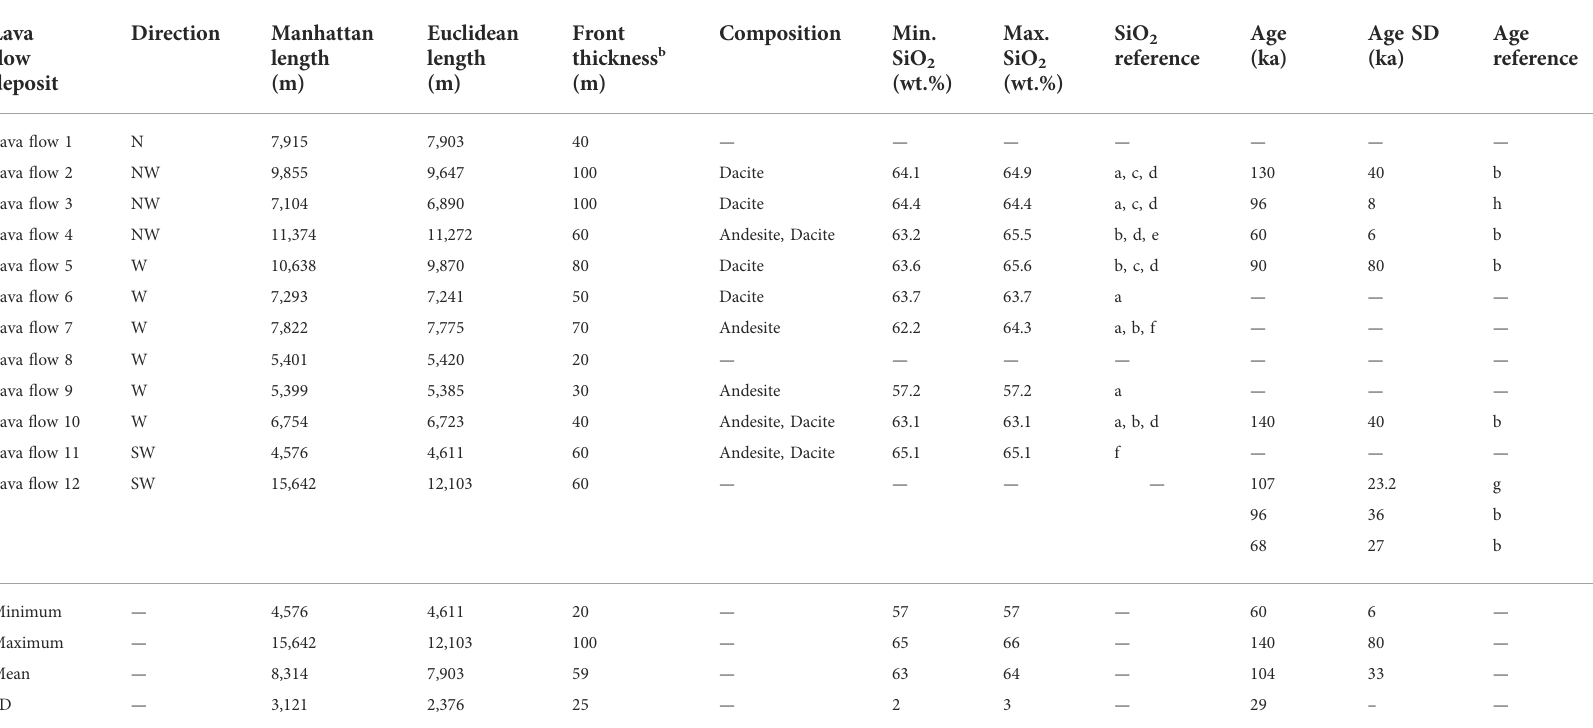
TABLE 2 Physical and geochemical data of the 12 lava fl ow deposits of the San Pedro volcano. a Francis et al. (1974a); b Bertin and Amigo (2019); c Mamani et al. (2008); d Godoy et al. (2014); e Godoy et al. (2017); f O ’ Callaghan and Francis (1986); g Delunel et al. (2016); h González-Maurel et al., 2019b. Front thickness measurements were taken from Bertin and Amigo (2019). Manhattan and Euclidean lengths were measured with QGIS. The Abbreviations: wt.% means weight percentage and SD means standard